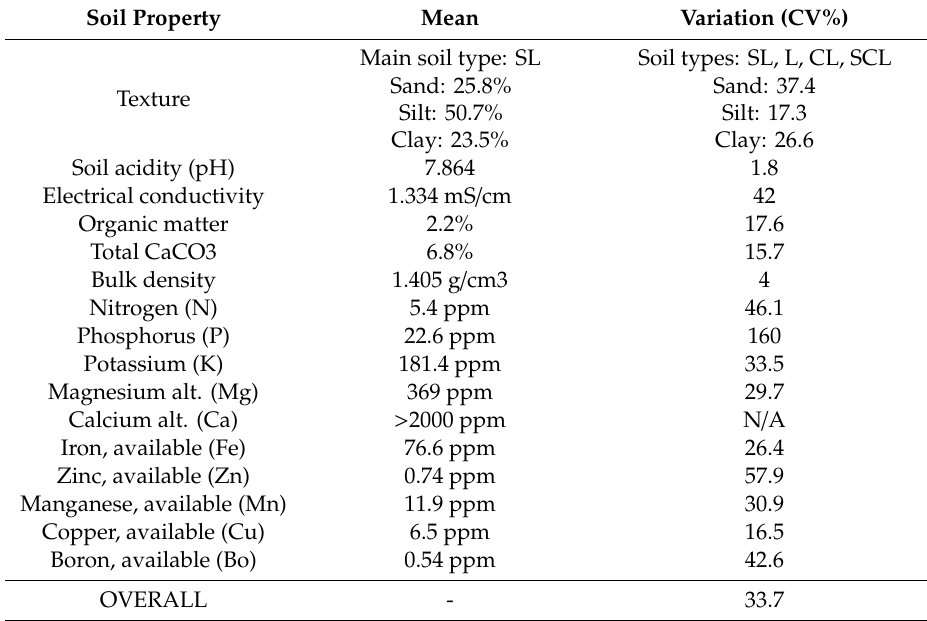
Table 2. Analyzed soil properties in the samples and their mean and variation